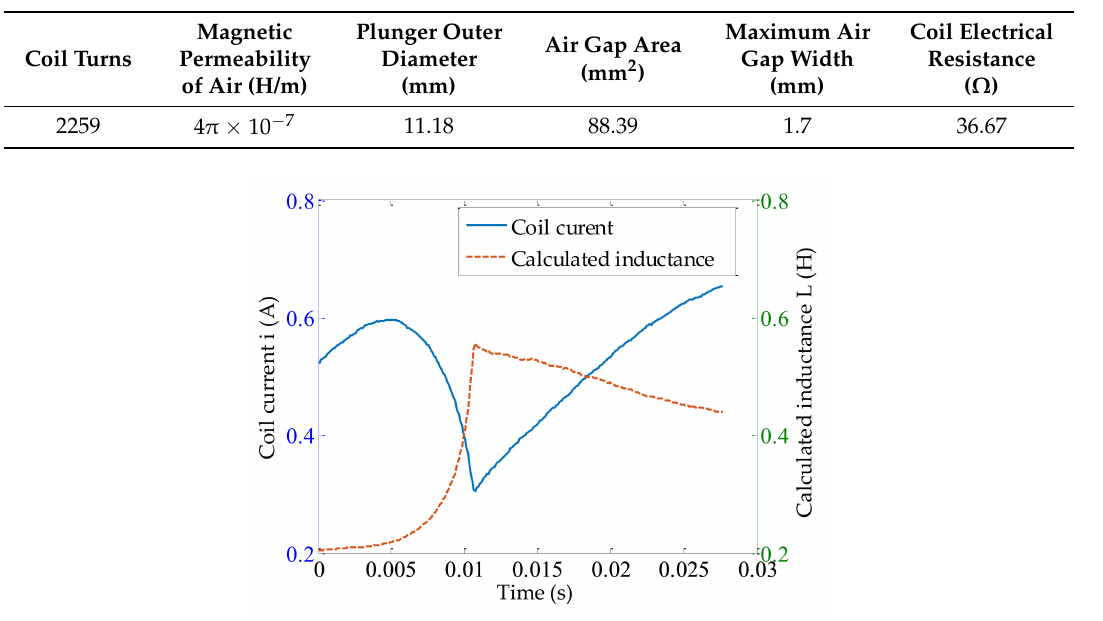
Figure 8. Calculated inductance (ˆ L ) as a function of measured current ( i ) during air gap decreasing (solenoid is being